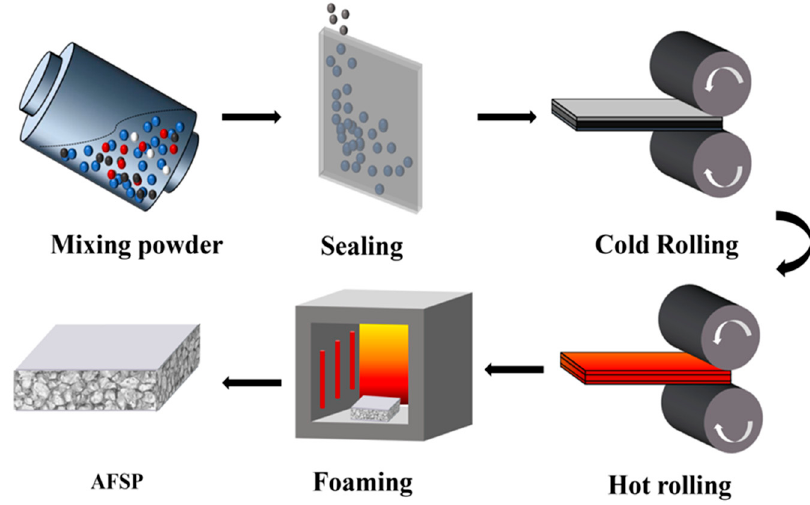
Figure 1. Schematic illustration of the preparation process of AFS. Table 1. Mixed powder composition and particle size [22].